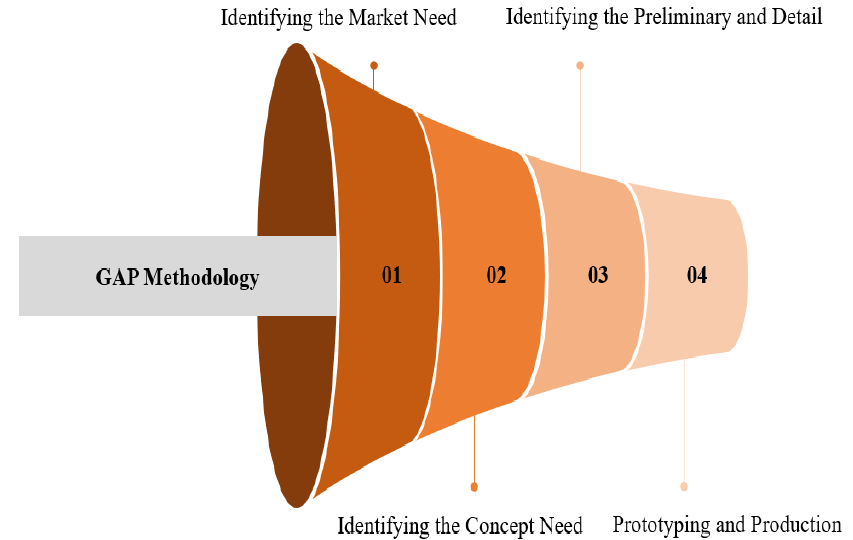
Figure 11. GAP Methodology